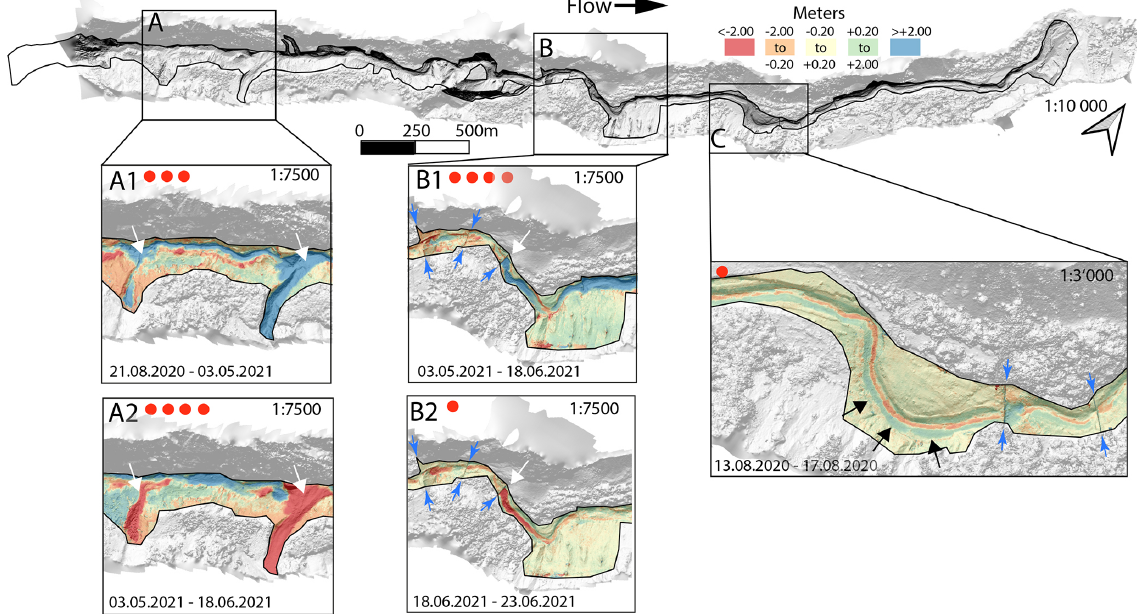
Figure 2. Hillshade of Illgraben section covered by autonomous UAV flights. Solid black outlines enclose areas mapped by DEM differ- encing. Zoomed-in boxes focus on erosion and deposition features, as shown by DEM differences. Times of flight pairs are indicated at the bottom of each zoomed-in box. Red dots represent the number of debris flows occurring between flights, as registered by the debris flow observatory of the Swiss Federal Institute for Forest, Snow and Landscape Research WSL (Badoux et al., 2009). Boxes A and B illustrate memory effects, with erosion concentrated in areas of previous deposition (white arrows). A and B show the cases for tributary deposition within the channel and debris flow deposition behind a check dam, respectively. Box C highlights lateral levee formation and in-channel erosion (black arrows). Color map gives erosion ( − ) and deposition ( + ) in meters. Note that scaling factors are relative among zoomed-in boxes. In Boxes B1, B2, and C, thin blue arrows indicate the location of check